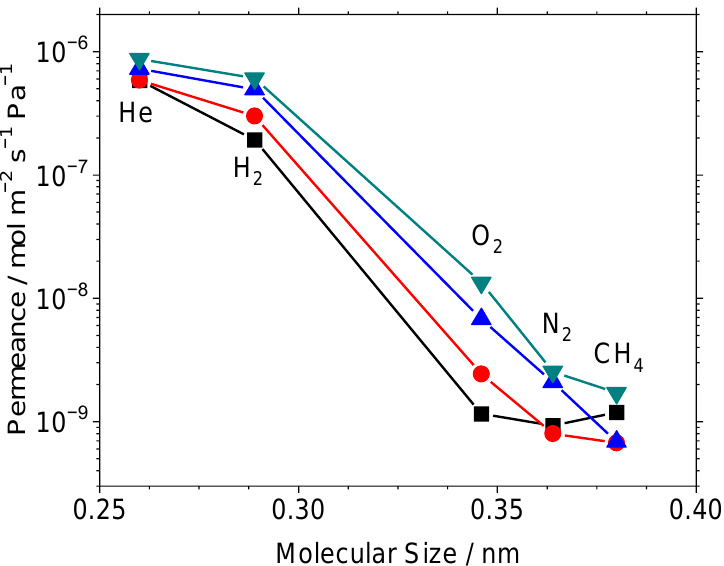
Figure 4. Permeance of several gases at 650 °C after CVD for various Si/Ta precursor ratios: Si-650 [ ■ ], Si-3Ta-650 [ ● ], Si-10Ta-650 [ ▲ ], Si-40Ta-650 [ ▼ ]. One potential explanation for the increase in pore size control and enhancement in selectivity for O 2 , N 2 and CH 4 gases is that the addition of TaEO resulted in a slower deposition rate. As Figure 5 shows, the decline in gas permeance versus CVD time was slower with increasing TaEO levels. This slower decline in gas permeation may have been caused either by a slower deposition rate leading to a slower pore closure or by interactions of TaEO with TEOS to form larger pores during the deposition process. The addition of secondary precursors to the CVD mixture has been shown previously to slow the pore closure rate [42].